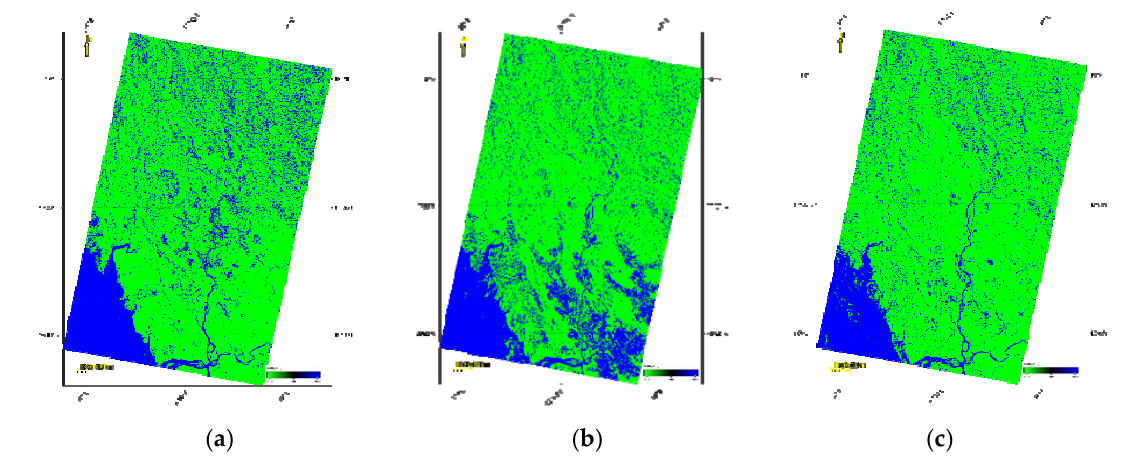
Figure 12. Sentinel SAR-1 images of the flood extension map; ( a ) May, ( b ) August, and ( c ) October 2019, Myanmar.